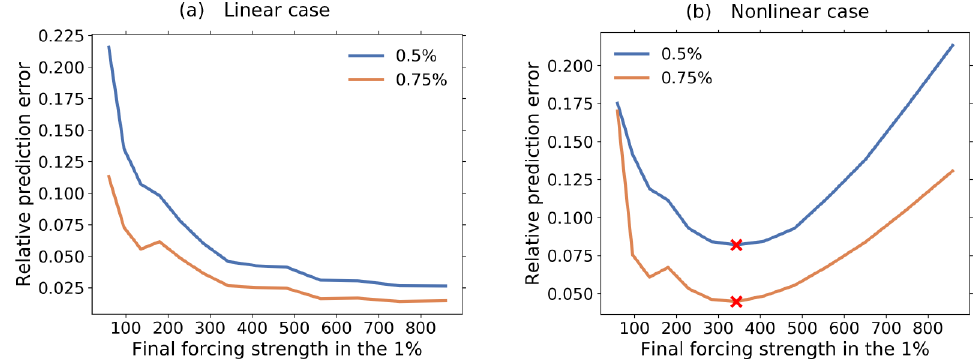
Figure 2. Toy model example for the identification of the linear regime by using additional experiments. Shown is the relative prediction error (Eq. 10) for the response of 0.5% and 0.75% experiments as obtained from the response function calculated by the RFI method from 1% experiments. The relative prediction errors are plotted against the final forcing strengths of a sequence of 1% experiments with increasing time series length. The crosses at the minima indicate the final forcing strength for which the response function is optimally recovered (see text). (a) shows the behavior for the fully linear toy model ( a = 0) and (b) the behavior in the presence of nonlinear contributions to the response ( a = 5 × 10 − 5 ). For the purpose of demonstrating more clearly the increase in the relative prediction error for a decrease in the forcing strength, we include in the plot cases where the forcing strength is extremely small, corresponding to very small time series lengths. To deal with such cases, we set for a number of data points N < 30 the number of timescales M = N (see parameters for the RFI method in Part 1). For such small number of timescales, usually no plateau in the singular values spectrum is found (step 2 of Fig. 1 in Part 1). Therefore, for these special cases we also modify the algorithm to interpret the two smallest singular values as a plateau, since their small magnitude makes them have a similar effect to those singular values belonging to the plateau itself. In addition, to illustrate the most general case where χ(t) is not known to be monotonic, we exclude here the monotonicity check (step 6 of Fig. 1 in Part 1).